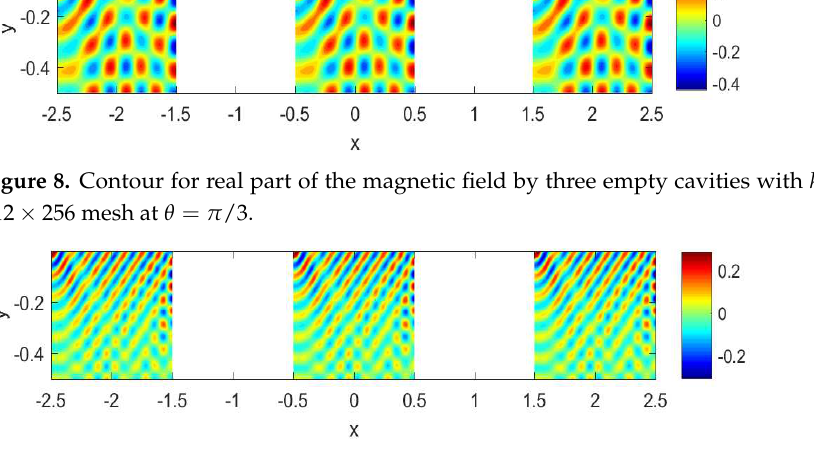
Figure 9. The real part of the magnetic field by three empty cavities with k 0 = 16 π m − 1 of 1024 × 512 mesh at θ = π